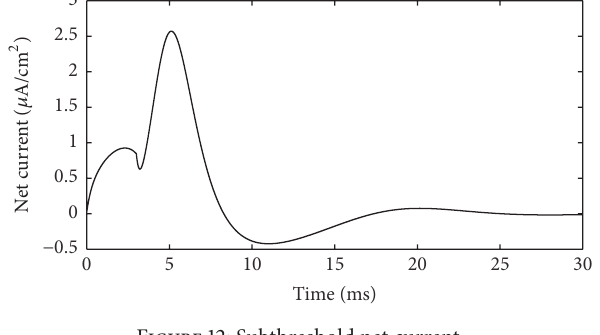
Figure 14: Power ratio of Na + and K + channels (subthreshold).